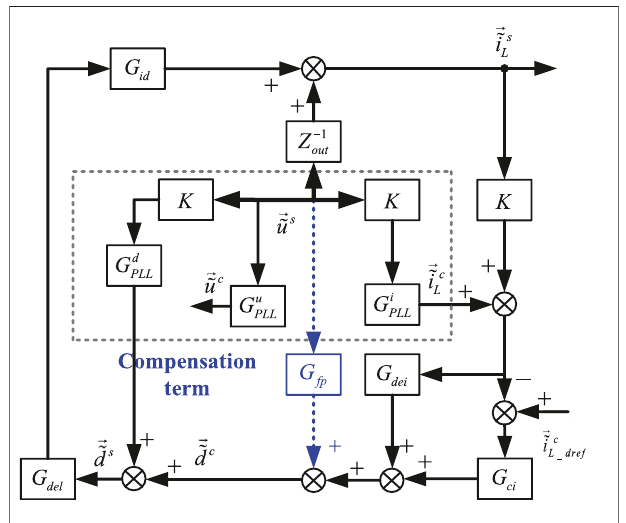
FIGURE 10 | Small-signal model of the grid-connected